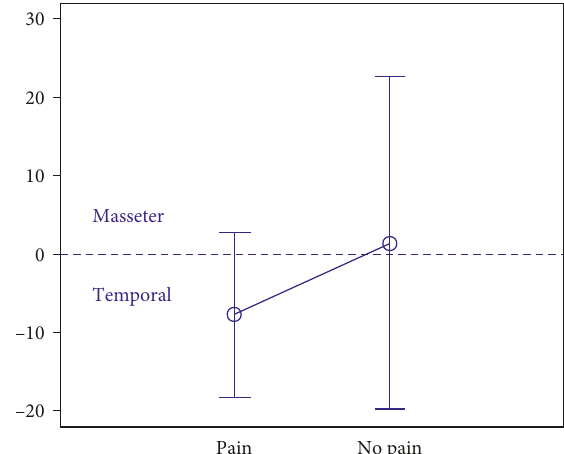
Figure 3: Activity index at rest in group of individuals with